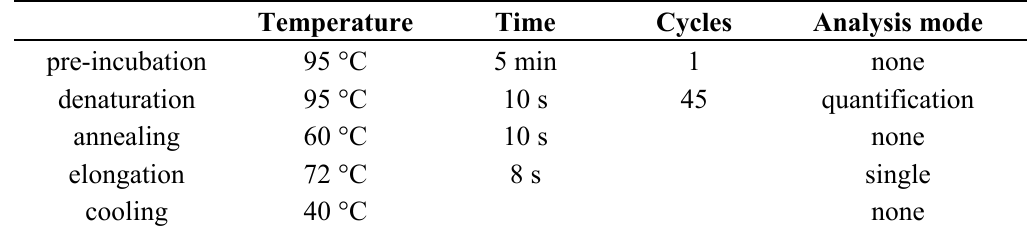
Table A2. Cycler